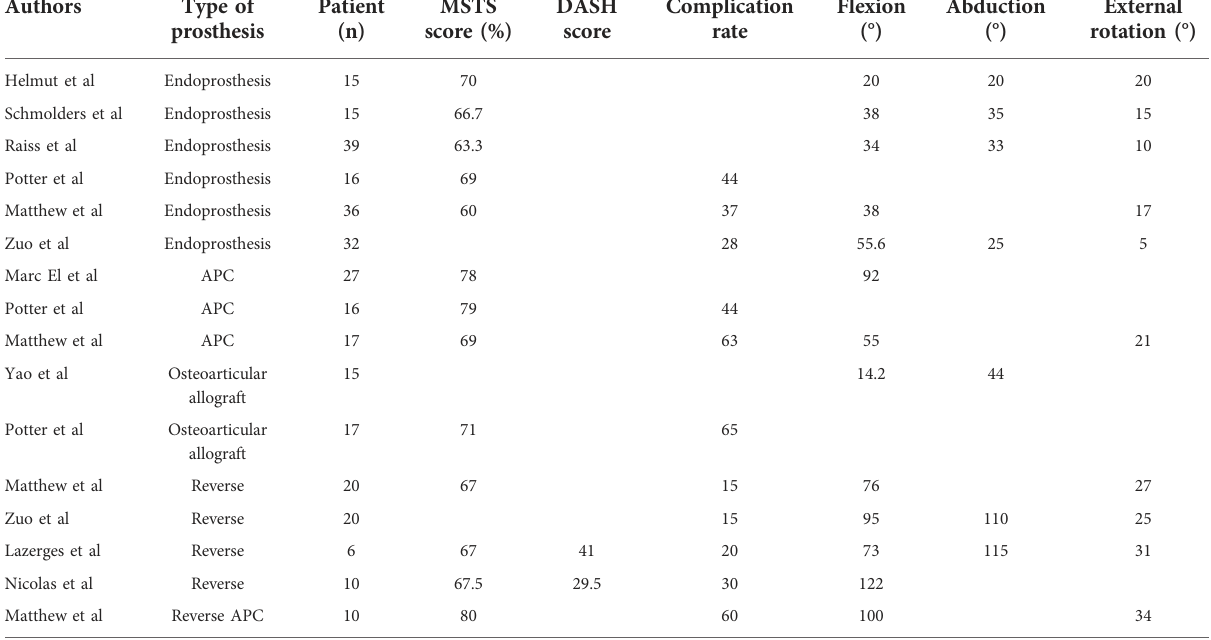
TABLE 2 Data from other studies on shoulder joint